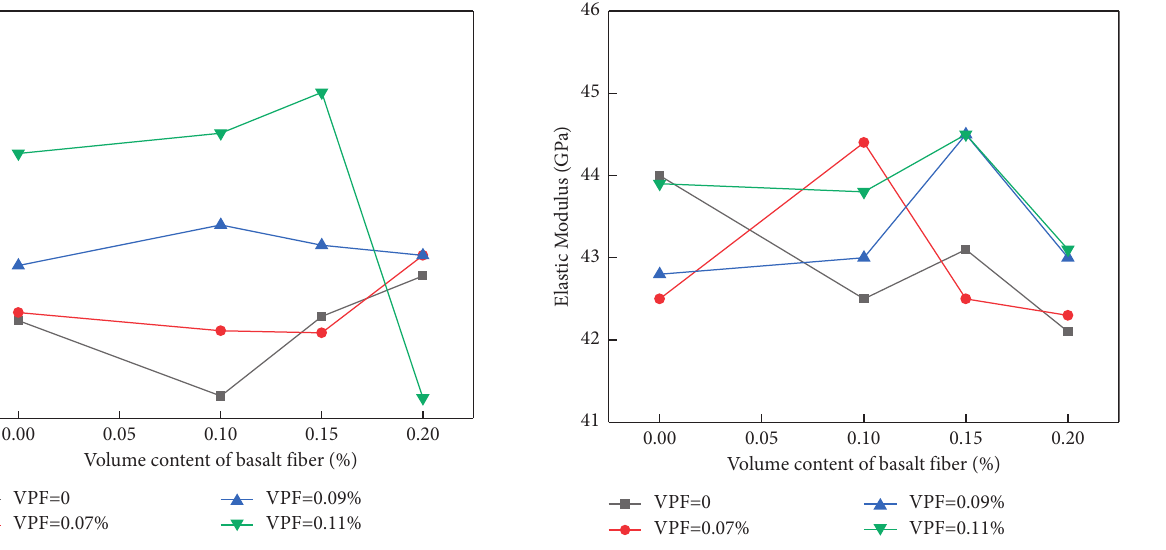
Figure 7: Compression modulus effect of concrete with different fiber volume